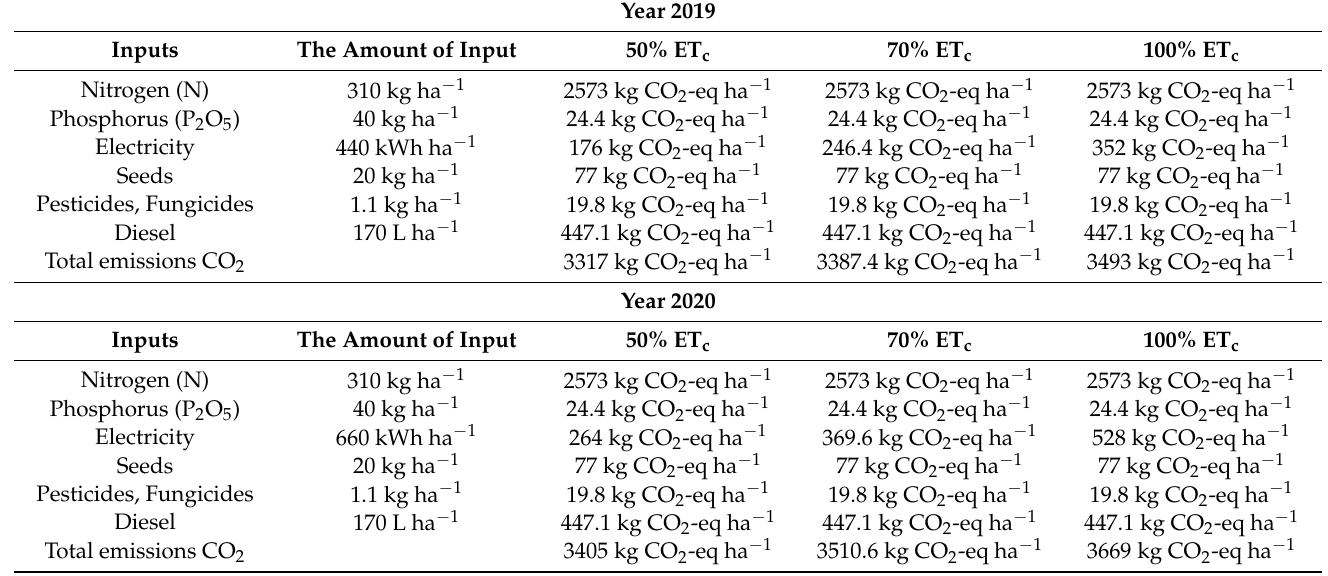
Table 8. Emission factors for each input used in maize production during the two years.